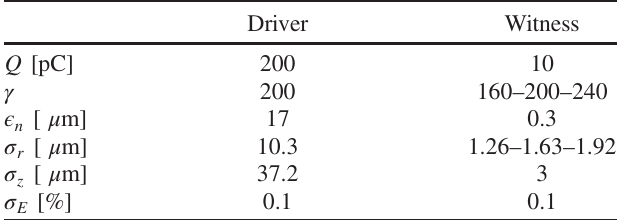
TABLE III. Second parametric scan.